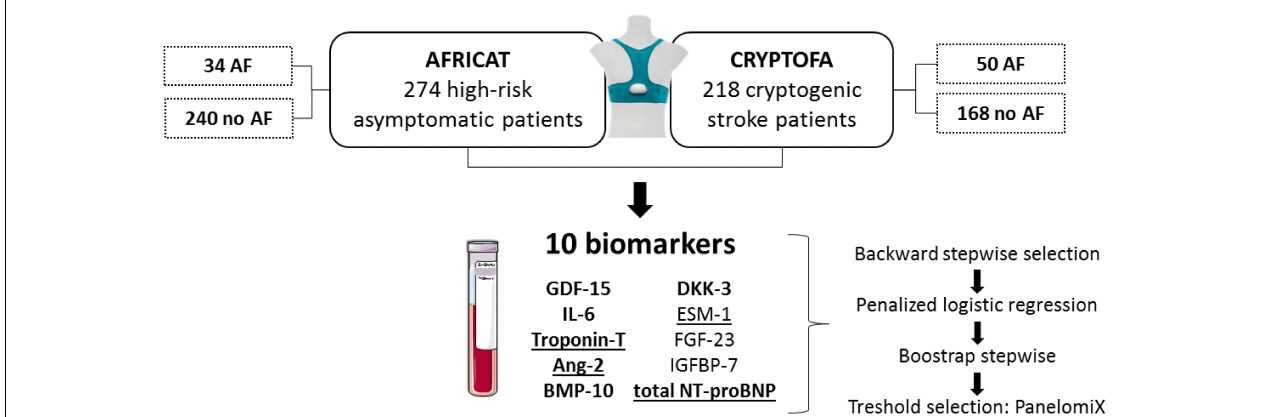
FIGURE 1 | Study design. Patients from two cohorts were included in the present study. In both cohorts, patients were monitored for 28 days to identify paroxysmal AF patients. Biomarkers displayed were measured in all patients. Those underlined had significantly higher concentration in AF patients from the AFRICAT cohort, while the ones in bold had significantly higher concentration in AF patients from the CRYPTOFA cohort. GDF-15 indicates growth differentiation factor 15; IL-6, interleukin 6; Ang-2, angiopoietin 2; BMP-10, bone morphogenic protein 10; DKK-3, dickkopf-related protein 3; ESM-1, endocan or endothelial cell specific molecule-1; FGF-23, fibroblast growth factor 23; IGFBP-7, insulin-like growth factor-binding protein 7; and NT-proBNP, N-terminal pro-brain natriuretic